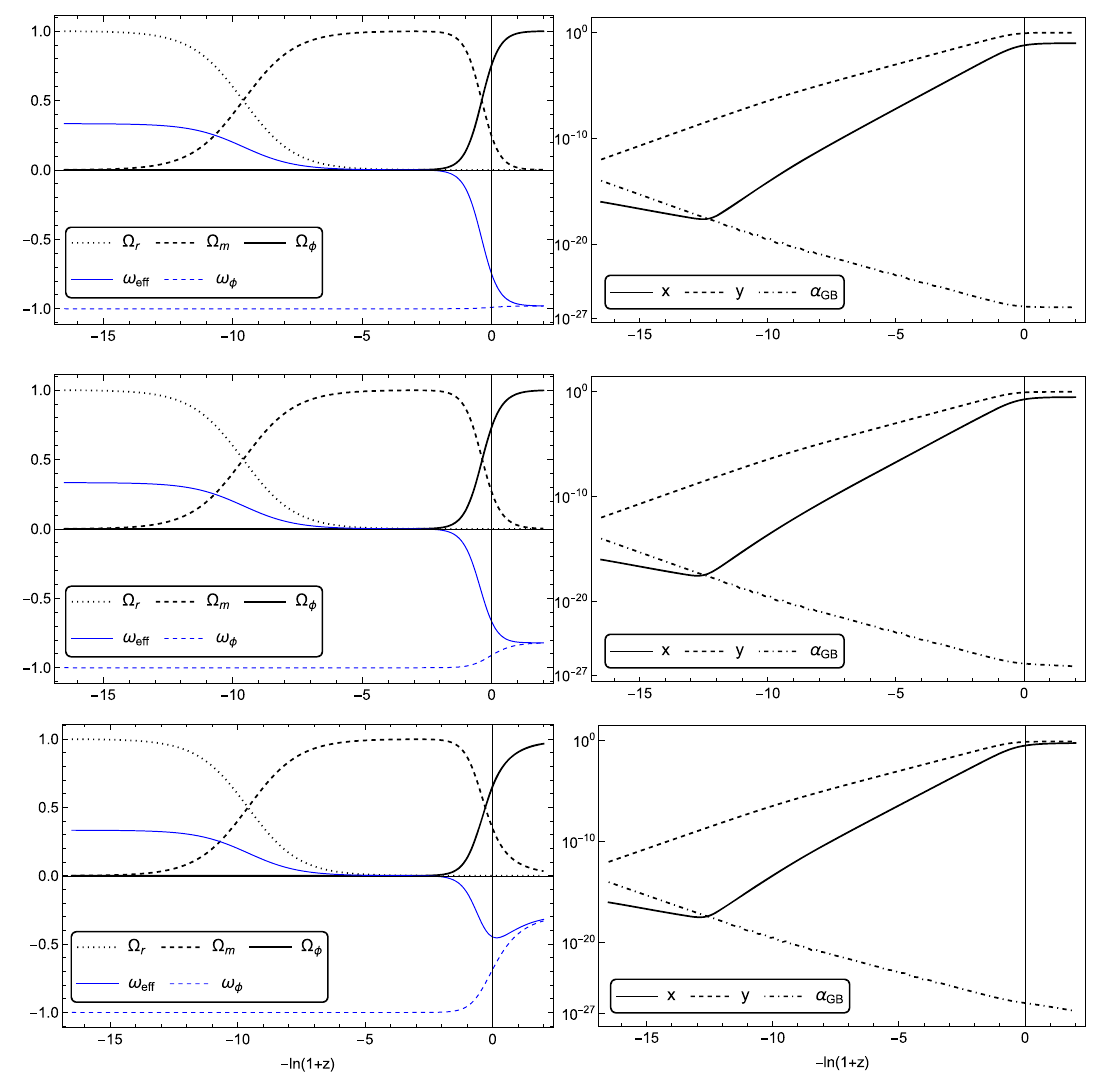
Fig. 2 Left: The red-shift evolution of the Ω i ( z ) , where i = r , m ,φ , the EoS parameter ω φ , and the effective EoS of the system ω eff . Right: The red-shift evolution of the x , y , α GB . In both columns, the λ value increases from top to bottom; λ = 0 . 1 , 0 . 3 , and 0 . 6,